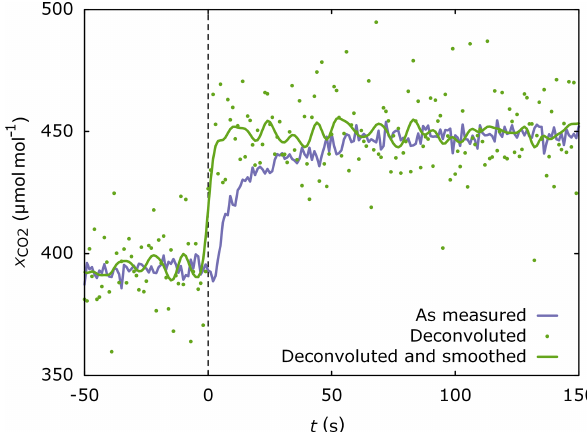
Figure 4. Response of COCAP to an abrupt change in CO 2 dry-air mole fraction x CO at the inlet at time t = 0s. The measured signal 2 reveals a dead time of 5s of the sampling system. Furthermore, the step change in x CO is smoothed out. Both effects are removed by 2 deconvolution at the cost of higher noise. Smoothing the deconvo- luted signal reduces the noise with only minor impact on the time response. Smoothing was carried out by convolution with a Gaus- sian function of 5s full width at half maximum